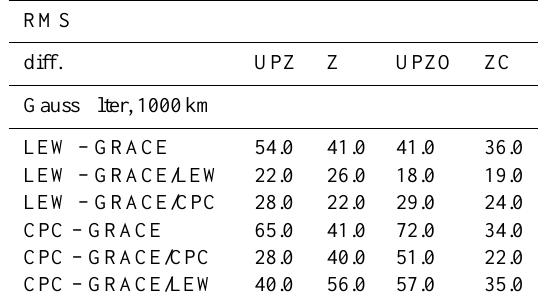
Table 4. Statistics of the differences between LEW and GRACE, and CPC and GRACE monthly estimates of the water storage. A Gaussian filter with 1000 km has been